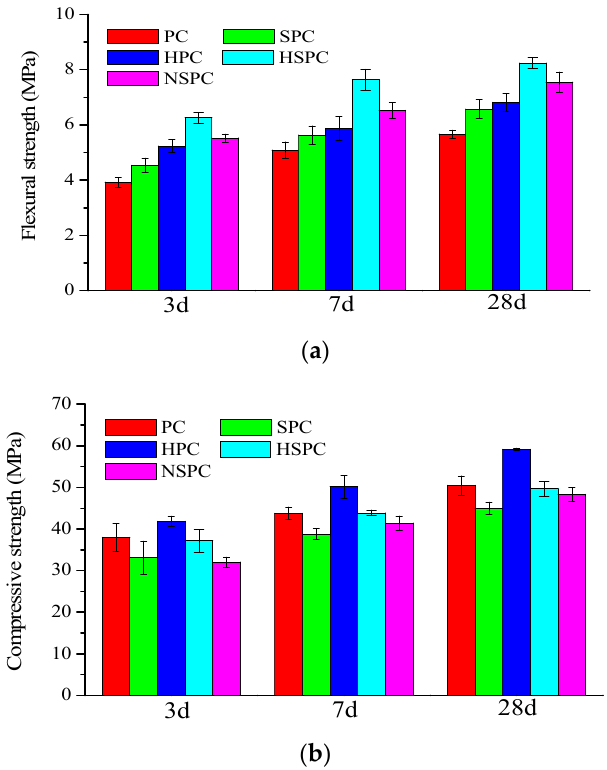
Figure 6. Flexural strength ( a ) and compressive strength ( b ) of cement composites after 3, 7 and 28 days of curing.